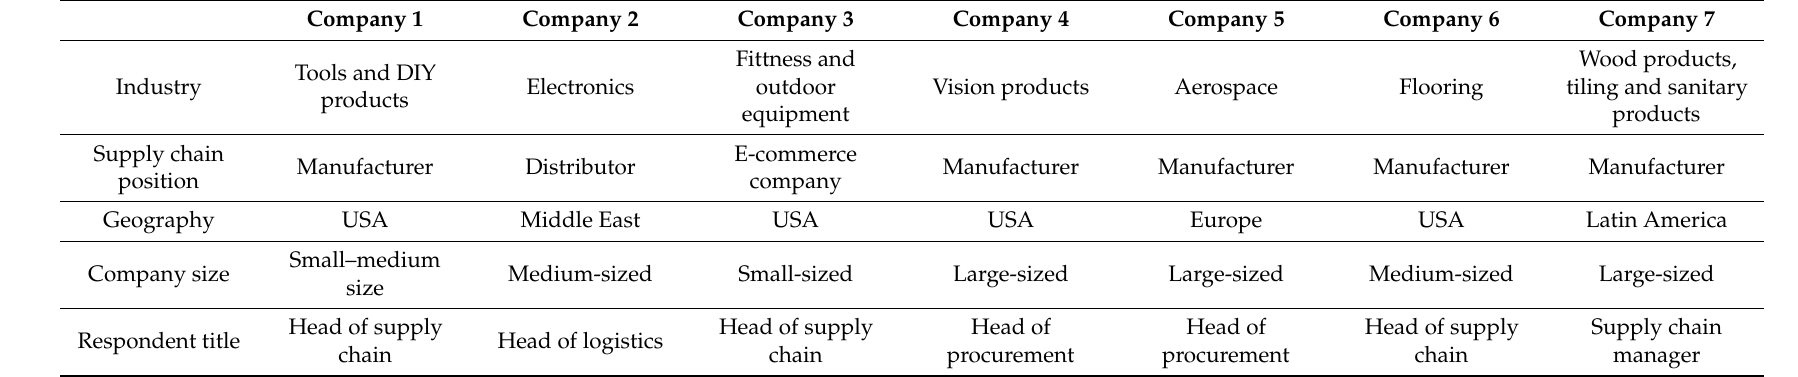
Table 3. Overview of